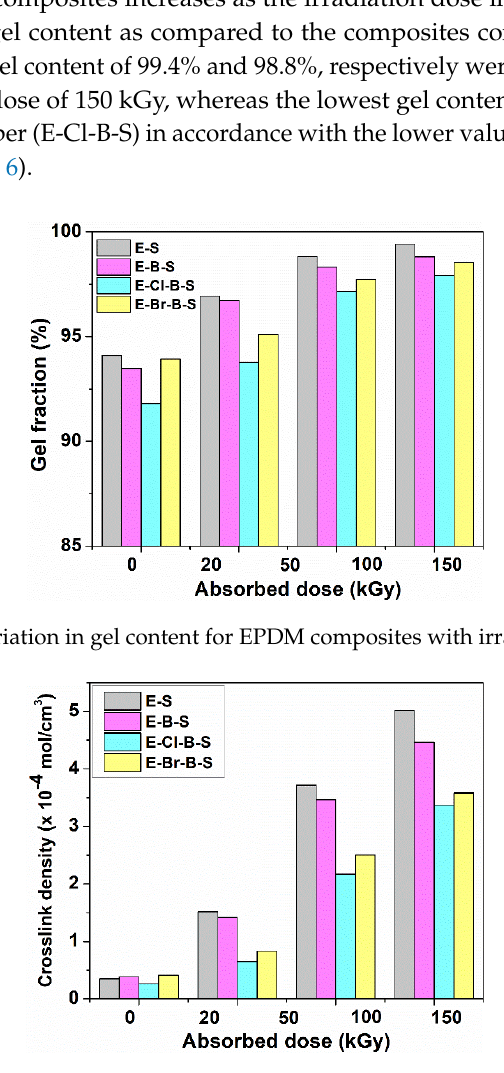
Figure 6. Dependence of the crosslink density on the irradiation dose for the investigated samples.